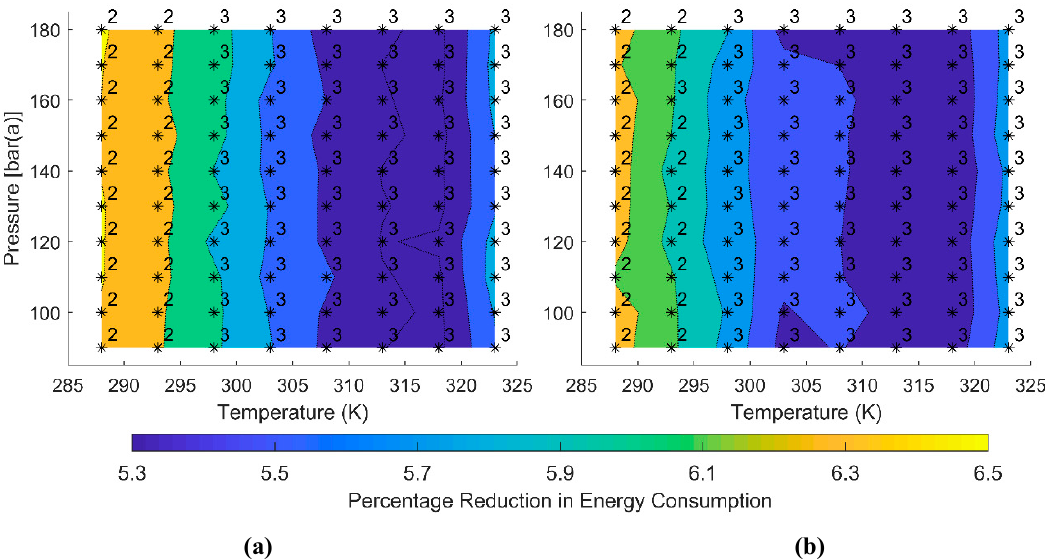
Figure 10. Reduction in energy consumption (%) for the unconstrained cases relative to the constrained cases with reduction in the number of compression stages overlaid, ( a ) post-combustion cases, ( b ) pre-combustion cases.